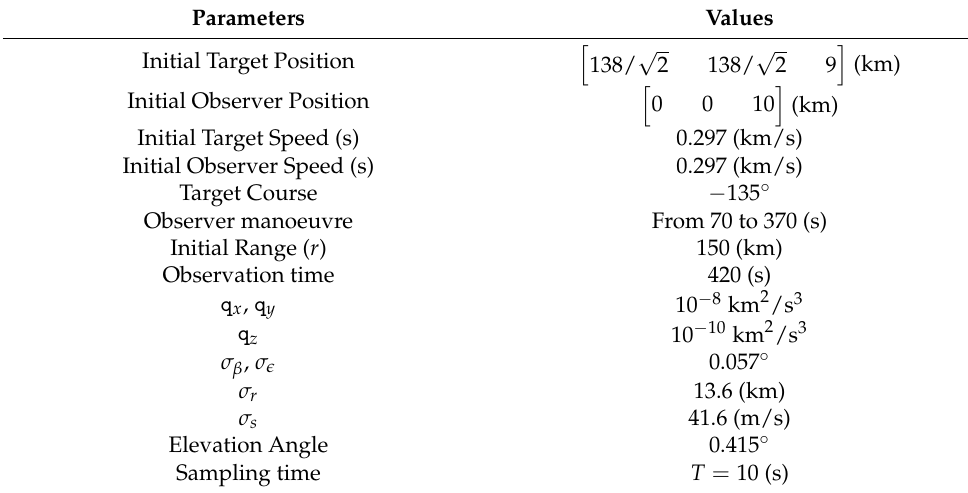
Table 2. Target & Observer Initial